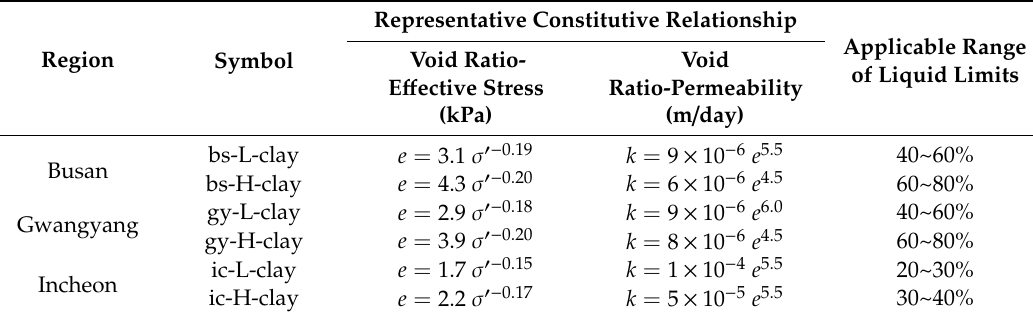
Table 3. Representative constitutive relationship